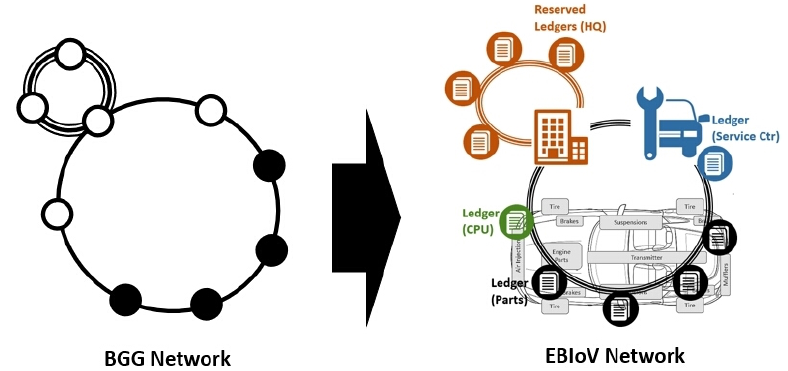
Figure 2. Adapting BGG for the EBIoV architecture